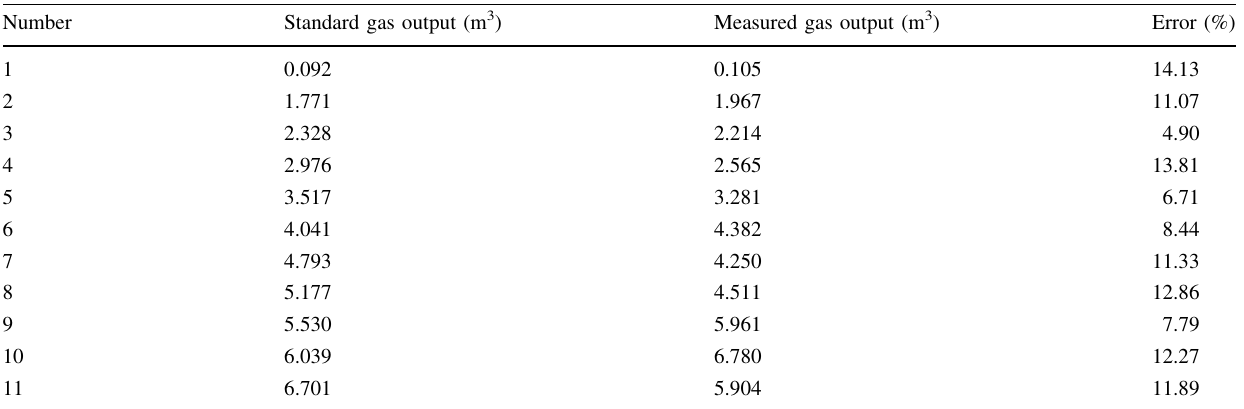
Table 2 Summary of laboratory test data